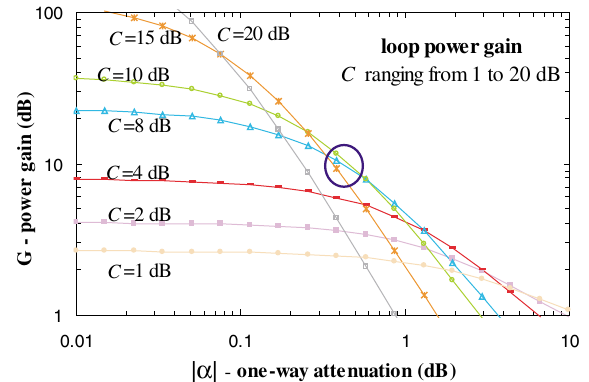
FIG. 5. (Color) Power gain in the resonant ring ( G ) as a function of the attenuation in the ring ( (cid:12) ) and the voltage coupling factor C . The circle marks a possible choice of parameters: j a j (cid:7) 0 : 5 dB and C (cid:7) 10 dB to get a power gain G around 9